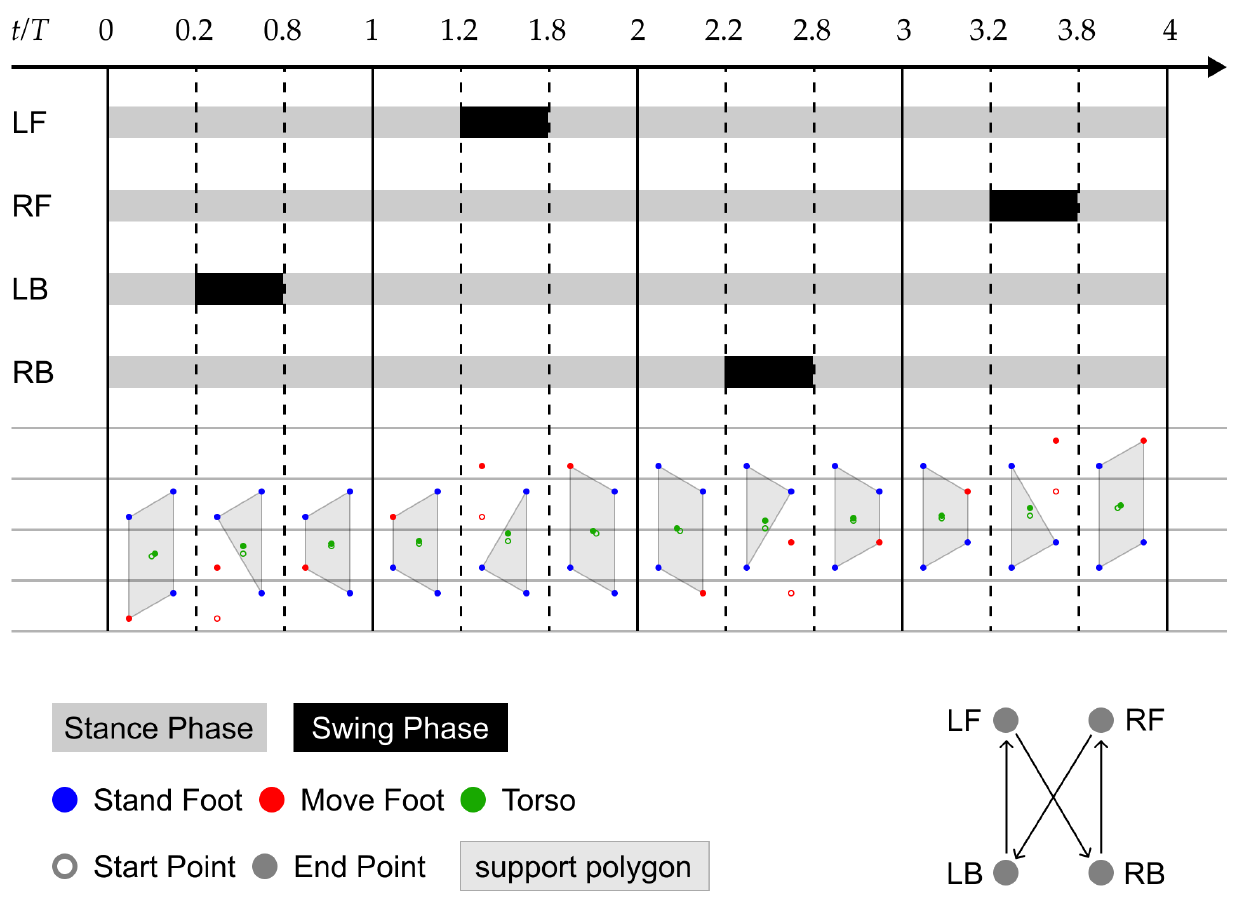
Figure 22. Gait cycle. During the 4 T time, each of the four legs of the robot completes a step movement in sequence.